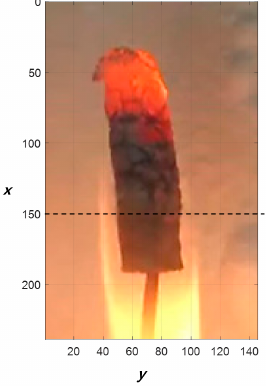
Figure 5. Image file of a wood pellet in flame burning mode and line of x = 150.